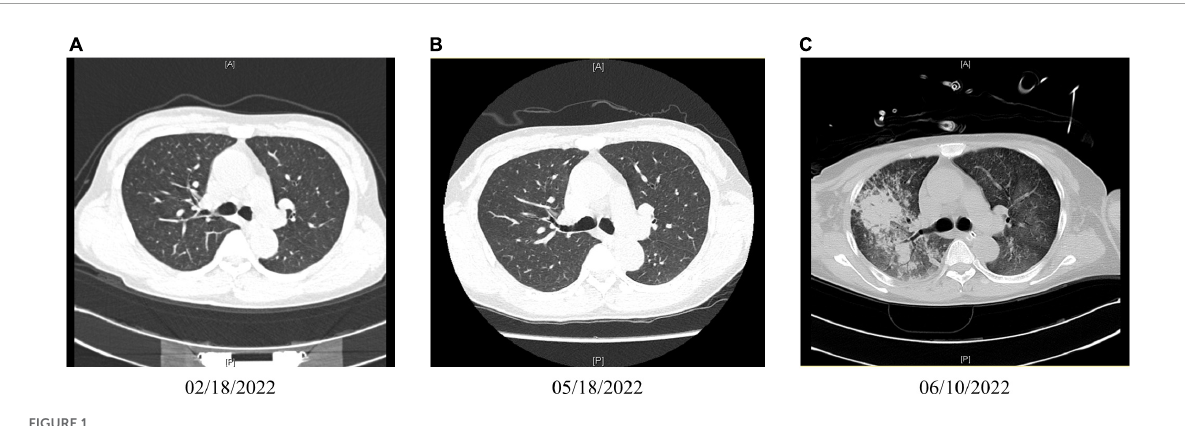
FIGURE1 Chest imaging. (A) Normal computed tomography (CT) image taken on February 18, 2022. (B) Normal CT image taken on May 18, 2022. (C) The CT image taken on June 10, 2022 shows scattered large high-density shadows in both